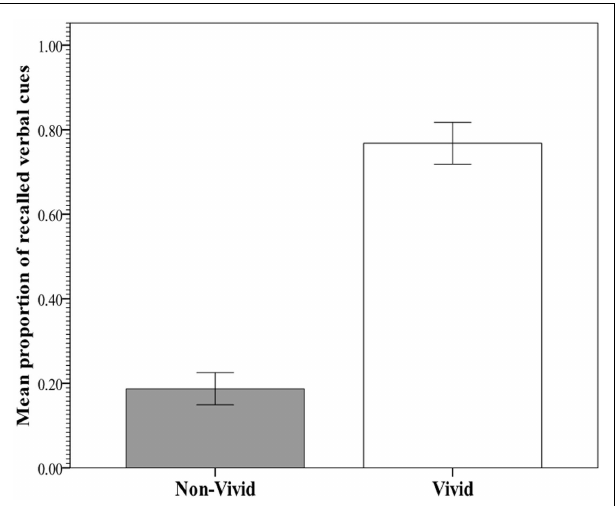
FIGURE 2 | Mean proportion of incidental recall for verbal cues corresponding to vivid (rating: 5–7) and non-vivid (rating: 2–4) images in Experiment 1.